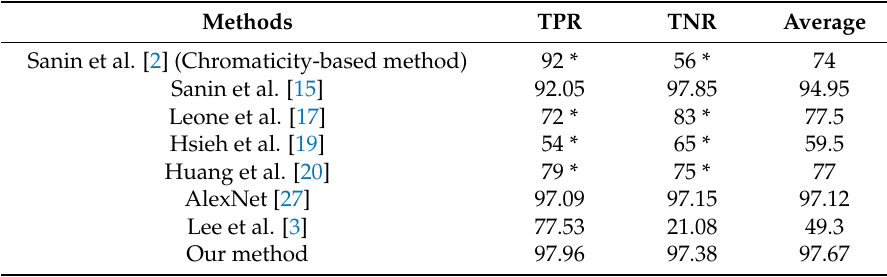
Figure 9. Experimental images using CAVIAR dataset: ( a ) Input images; ( b ) Ground truth images; and ( c ) Result images by our method. Table 8. Comparison of accuracy for CAVIAR dataset (unit: